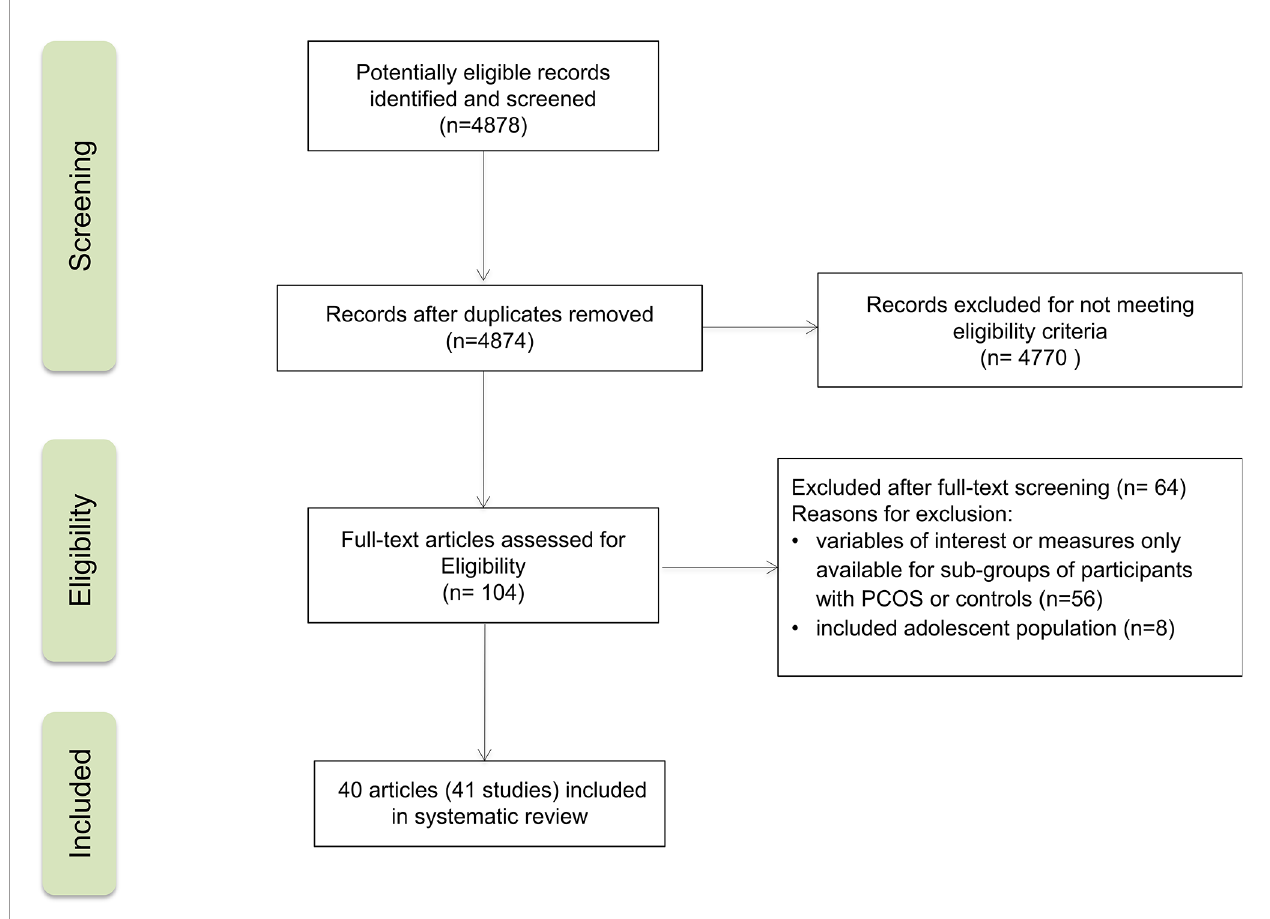
FIGURE 1 | PRISMA fl ow diagram of the study selection